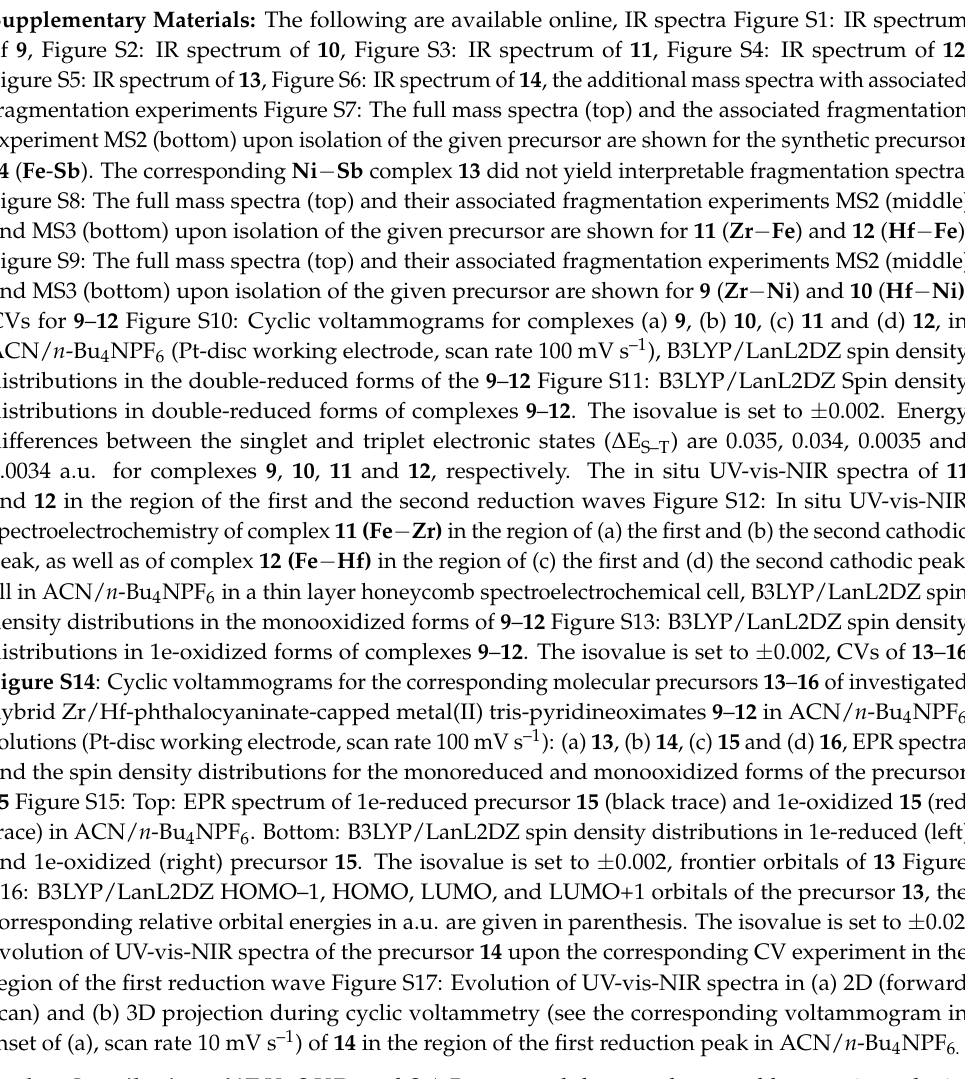
of 9 , Figure S2: IR spectrum of 10 , Figure S3: IR spectrum of 11 , Figure S4: IR spectrum of 12 , Figure S5: IR spectrum of 13 , Figure S6: IR spectrum of 14 , the additional mass spectra with associated fragmentation experiments Figure S7: The full mass spectra (top) and the associated fragmentation experiment MS2 (bottom) upon isolation of the given precursor are shown for the synthetic precursor 14 ( Fe - Sb ). The corresponding Ni − Sb complex 13 did not yield interpretable fragmentation spectra, Figure S8: The full mass spectra (top) and their associated fragmentation experiments MS2 (middle) and MS3 (bottom) upon isolation of the given precursor are shown for 11 ( Zr − Fe ) and 12 ( Hf − Fe ), Figure S9: The full mass spectra (top) and their associated fragmentation experiments MS2 (middle) and MS3 (bottom) upon isolation of the given precursor are shown for 9 ( Zr − Ni ) and 10 ( Hf − Ni), CVs for 9 – 12 Figure S10: Cyclic voltammograms for complexes (a) 9 , (b) 10 , (c) 11 and (d) 12 , in ACN/ n -Bu 4 NPF 6 (Pt-disc working electrode, scan rate 100 mV s –1 ), B3LYP/LanL2DZ spin density distributions in the double-reduced forms of the 9 – 12 Figure S11: B3LYP/LanL2DZ Spin density distributions in double-reduced forms of complexes 9 – 12 . The isovalue is set to ± 0.002. Energy differences between the singlet and triplet electronic states ( ∆ E S–T ) are 0.035, 0.034, 0.0035 and 0.0034 a.u. for complexes 9 , 10 , 11 and 12 , respectively. The in situ UV-vis-NIR spectra of 11 and 12 in the region of the first and the second reduction waves Figure S12: In situ UV-vis-NIR peak, as well as of complex 12 (Fe − Hf) in the region of (c) the first and (d) the second cathodic peak, density distributions in the monooxidized forms of 9 – 12 Figure S13: B3LYP/LanL2DZ spin density Figure S14 : Cyclic voltammograms for the corresponding molecular precursors 13 – 16 of investigated hybrid Zr/Hf-phthalocyaninate-capped metal(II) tris-pyridineoximates 9 – 12 in ACN/ n -Bu 4 NPF 6 solutions (Pt-disc working electrode, scan rate 100 mV s –1 ): (a) 13 , (b) 14 , (c) 15 and (d) 16 , EPR spectra and the spin density distributions for the monoreduced and monooxidized forms of the precursor 15 Figure S15: Top: EPR spectrum of 1e-reduced precursor 15 (black trace) and 1e-oxidized 15 (red trace) in ACN/ n -Bu 4 NPF 6 . Bottom: B3LYP/LanL2DZ spin density distributions in 1e-reduced (left) and 1e-oxidized (right) precursor 15 . The isovalue is set to ± 0.002, frontier orbitals of 13 Figure S16: B3LYP/LanL2DZ HOMO–1, HOMO, LUMO, and LUMO+1 orbitals of the precursor 13 , the corresponding relative orbital energies in a.u. are given in parenthesis. The isovalue is set to ± 0.02, region of the first reduction wave Figure S17: Evolution of UV-vis-NIR spectra in (a) 2D (forward scan) and (b) 3D projection during cyclic voltammetry (see the corresponding voltammogram in Inset of (a), scan rate 10 mV s –1 ) of 14 in the region of the first reduction peak in ACN/ n -Bu 4 NPF